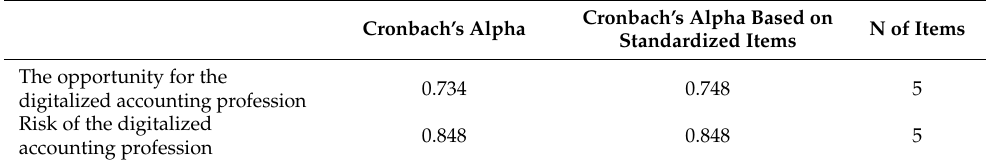
Table 3. Reliability